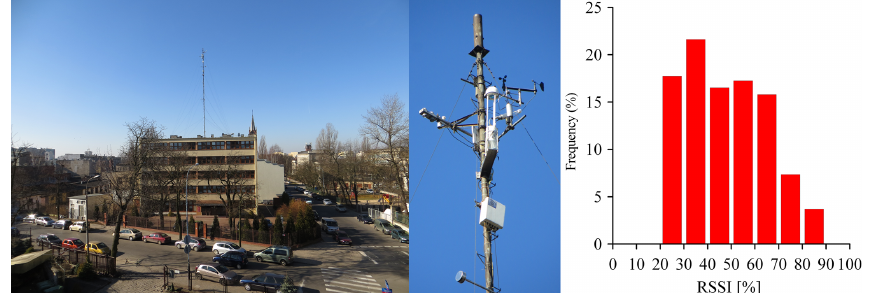
Figure 2. A FCH 4 measurement site in Łód´z (left) and instrumentation (middle). The right figure shows the frequency of measured 1h blocks of raw data in relation to the RSSI (Received Signal Strength Indicator) of Li7700 methane open-path analyser. Data recorded only in the case RSSI>20% were taken into